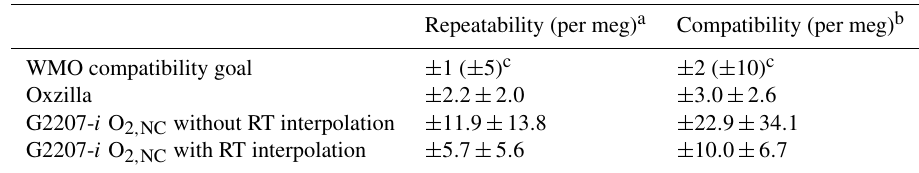
Figure 8. TT differences from declared values (measured–declared) ( ± 1 σ standard deviation) for the Oxzilla (red) and G2207- i O 2 , NC (blue) . The solid line indicates zero difference from the declared O 2 value of the TT, and the dashed lines indicate the WMO compatibility goal of ± 2 per meg and the extended goal of ± 10 per meg. Table 3. Repeatability and compatibility goals and achievements for each analyser.